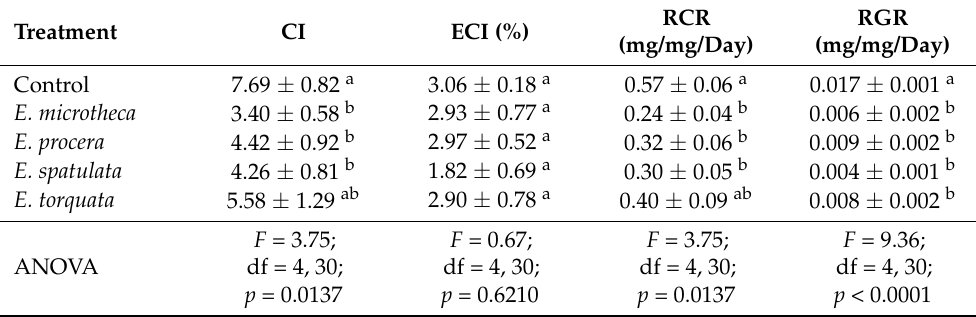
Table 7. The effects of low-lethal exposure to Eucalyptus essential oils (LC 30 concentration) on nutritional indices (Mean ± SE) of Rhyzopertha dominica